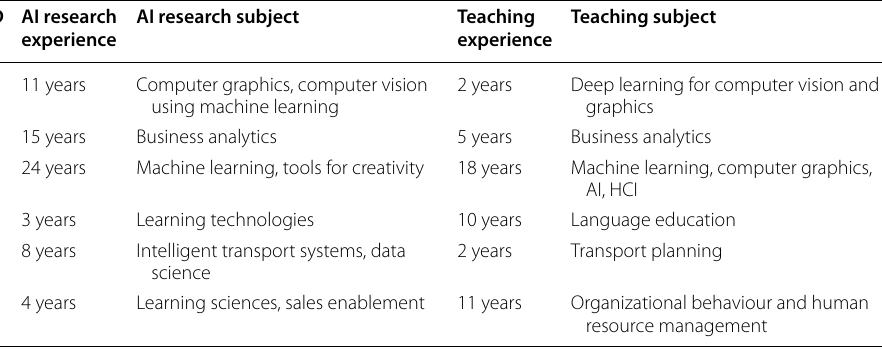
Table 7 Summary of the AI experts’